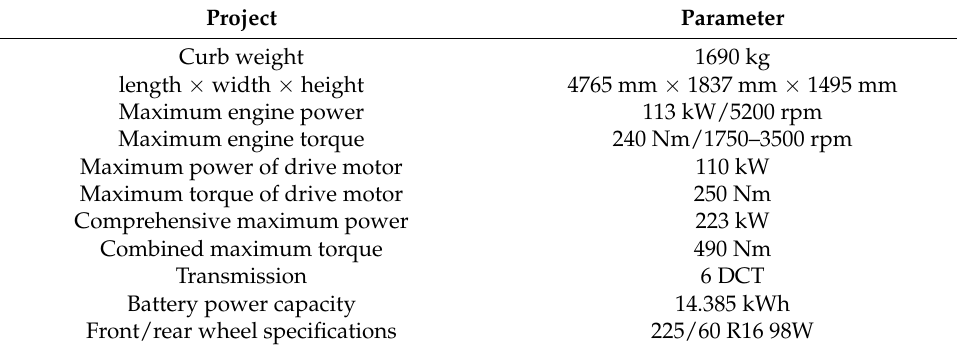
Table 1. The basic parameters of the test